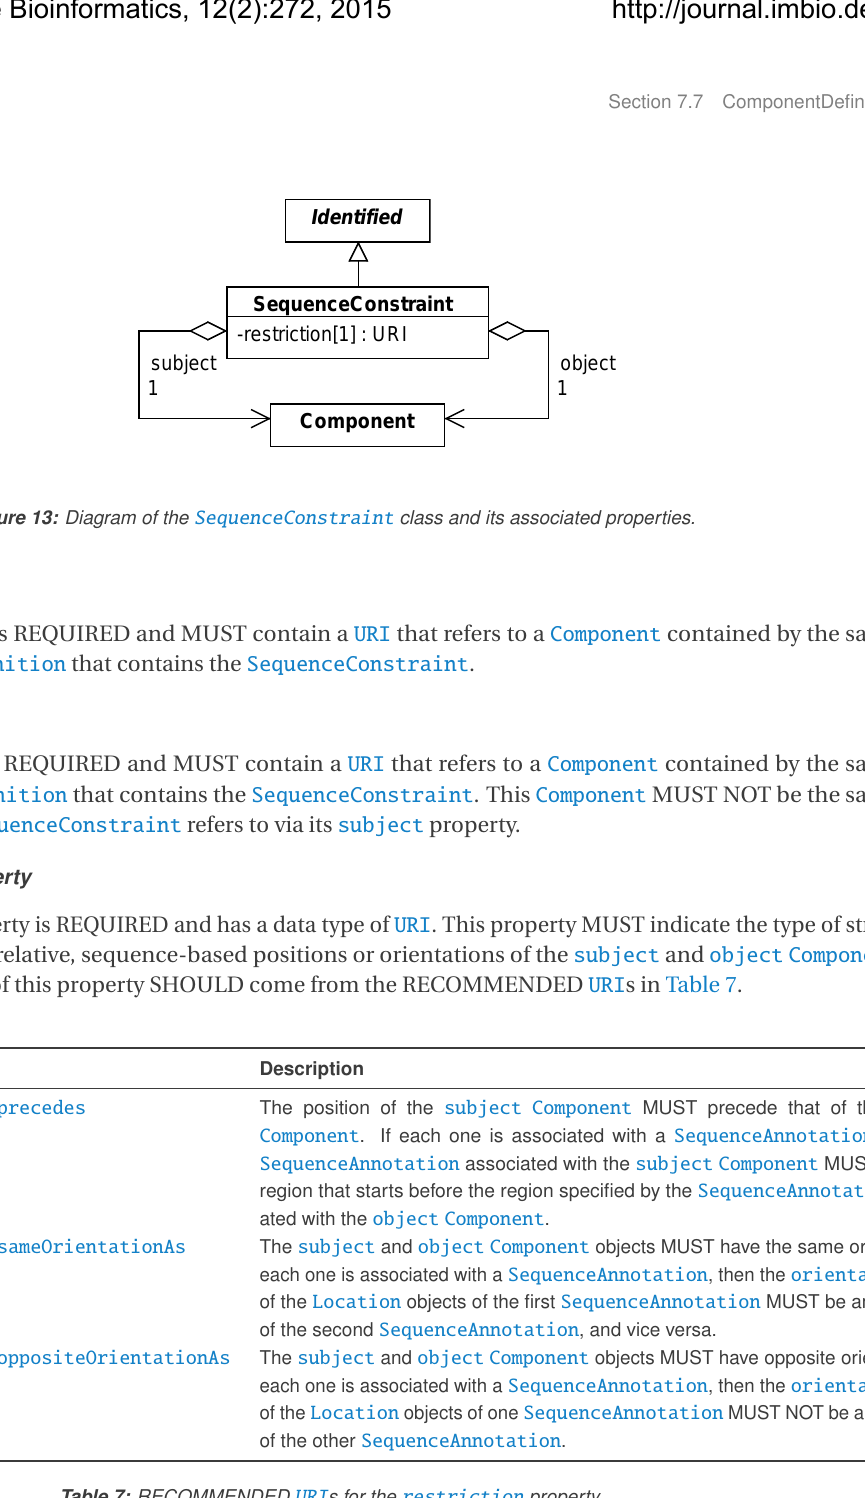
Table 7: RECOMMENDED URI s for the restriction